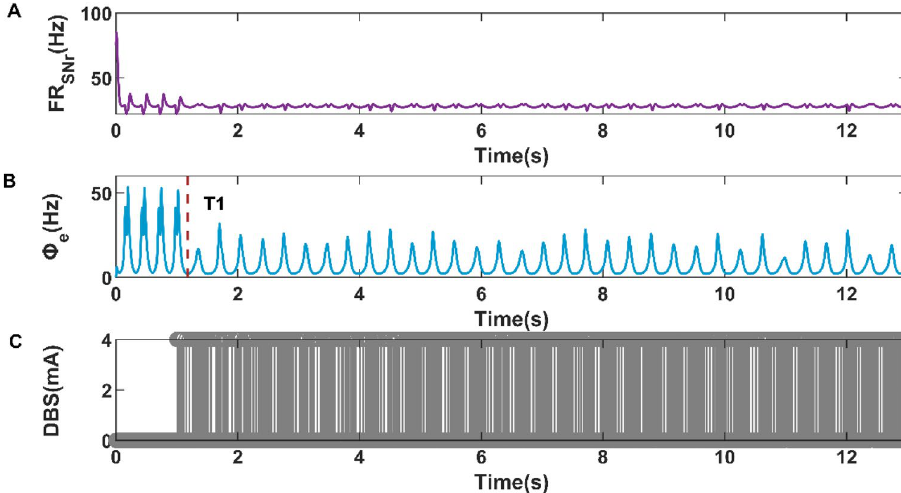
Figure 11. Variations of firing rate of SNr ( A ), firing activity of cerebral cortex ( B ), and the current of closed- loop DBS ( C ) during the closed-loop DBS control when the expected firing rate is 28.4144